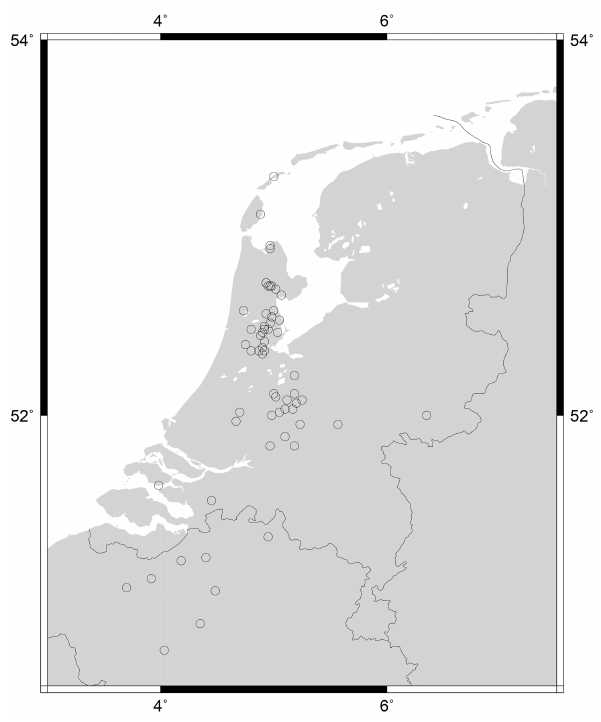
Figure 3. Damage reports compiled from various sources related to the 4 August 1674